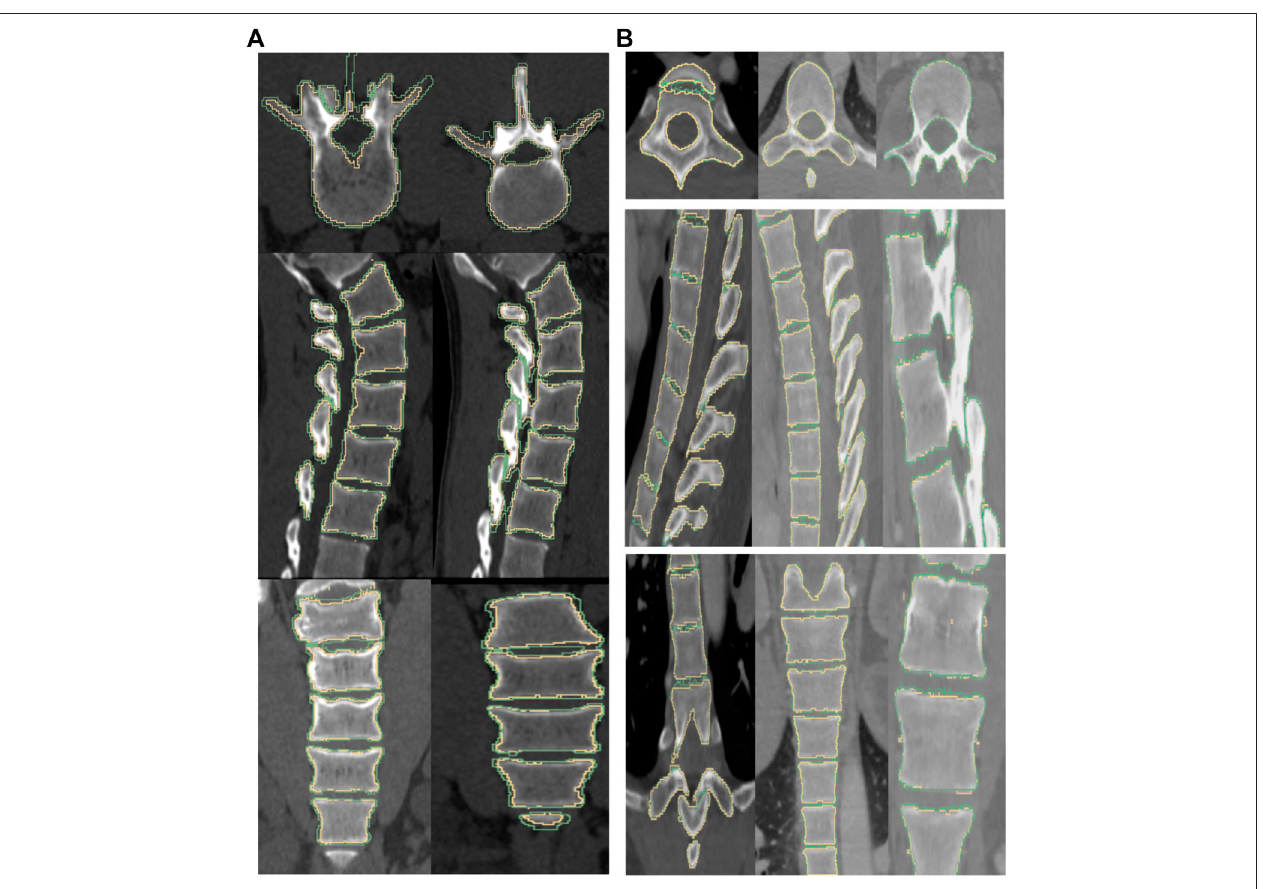
FIGURE 7 | The boundary of the segmentation (yellow) and groundtruth (green) overlaid on top of the image for a subject from Database 1 (left column) and Database2(rightcolumn).( Fromtoptobottom )axial,sagittalandcoronalviews. Note: Wenoticedthatsomeofthemanuallylabelled segmentationsprovidedintheCSI Database had errors, especially in the thoracic regions, and this could adversely affect the quality